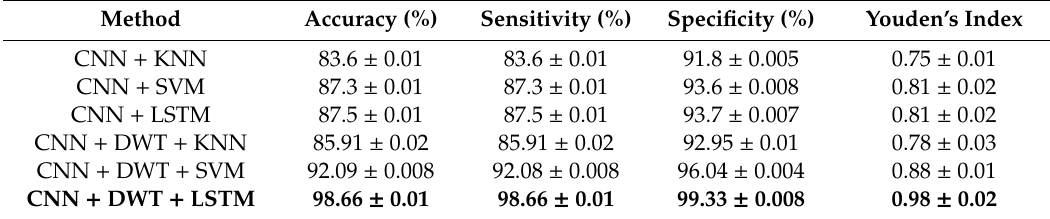
Table 6. Classification performance of CNN features of brain tumor